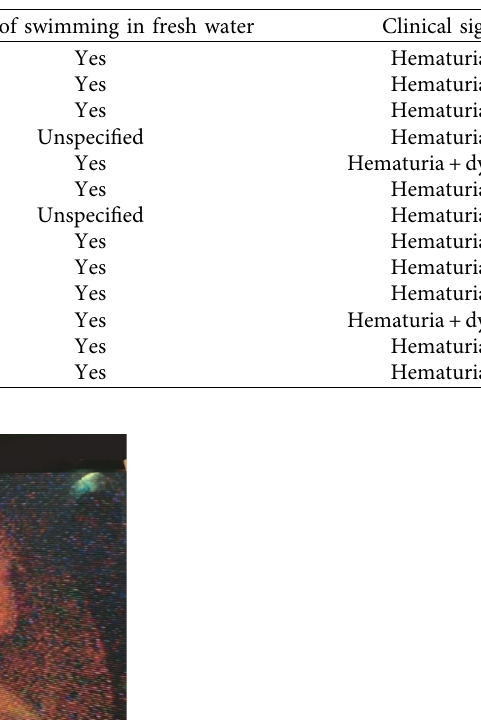
Table 1: Clinical information of the patients.